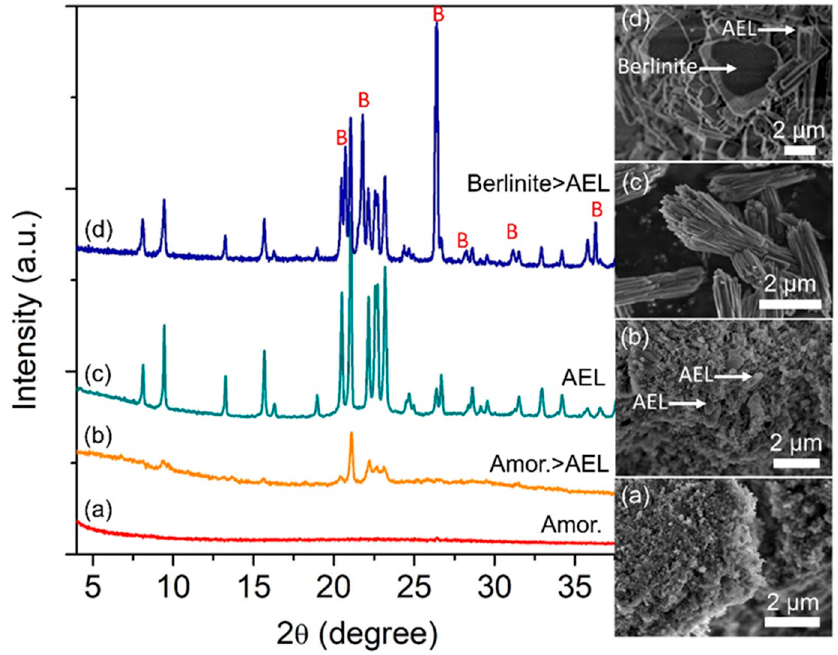
Figure 2. XRD patterns and FESEM micrographs of ( a ) E-5, ( b ) E-6, ( c ) E-3 and ( d ) E-7 samples prepared using the ionogel of 1.0Al: 1.8P: 0.3Si: 38[PPy]Br and heated at 130 °C, 140 °C, 150 °C and 160 °C for 133 h, respectively.